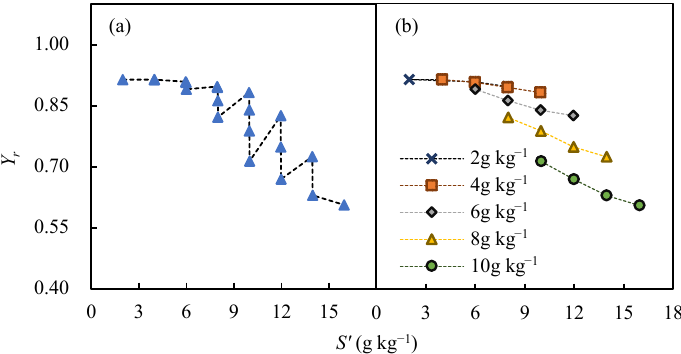
Figure 6. ( a ) Relationship between Y r and S ’ when M = 500 mm and W 0 = 0.85 θ fc ; ( b ) relationship between Y r and S ’ when M = 500 mm and W 0 = 0.85 θ f c for different S 0.